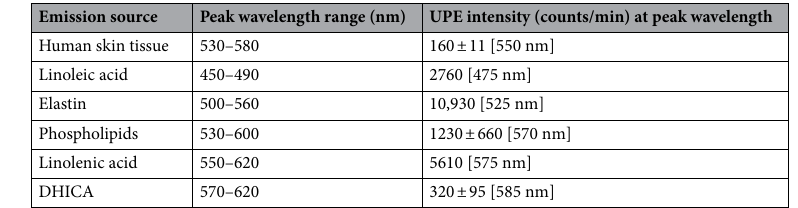
Table 1. Peak (relative intensity > 0.9) wavelength ranges of UVA-induced UPE spectra and UPE intensities at the spectral peak wavelength. Data are presented as means ± SD (n = 3 human skin tissue, n = 4